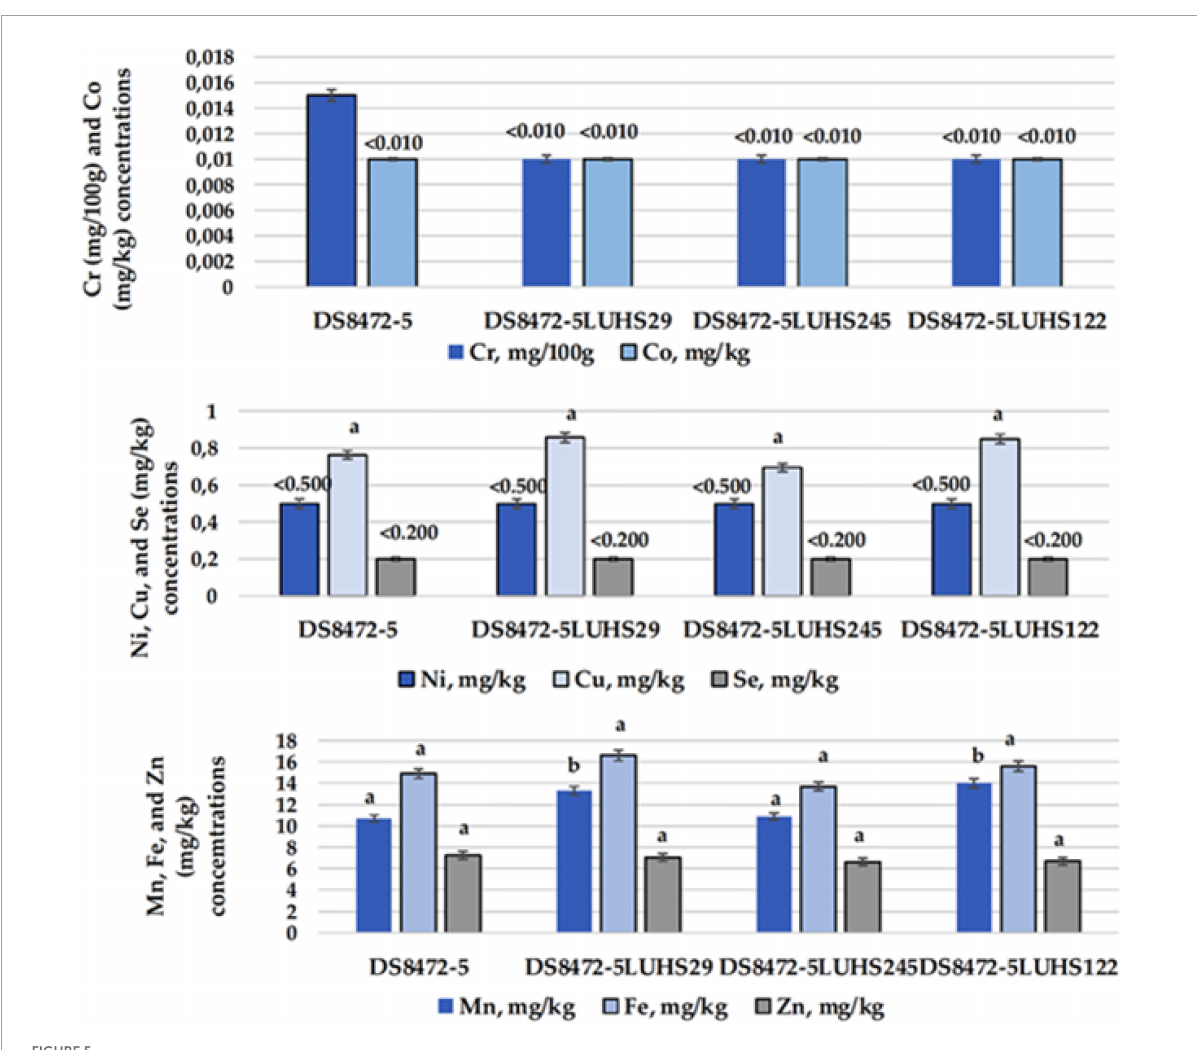
FIGURE5 Essential micro-element concentrations in wheat wholemeal (WCW) (DS8472-5) samples. LUHS29, treated with Pediococcus acidilactici ; LUHS245, treated with Liquorilactobacillus uvarum ; LUHS122, treated with Lactiplantibacillus plantarum LUHS122. Results presented as the mean ( n = 3) ± standard error (SE). a , b Means with different letters in column are significantly different ( p ≤